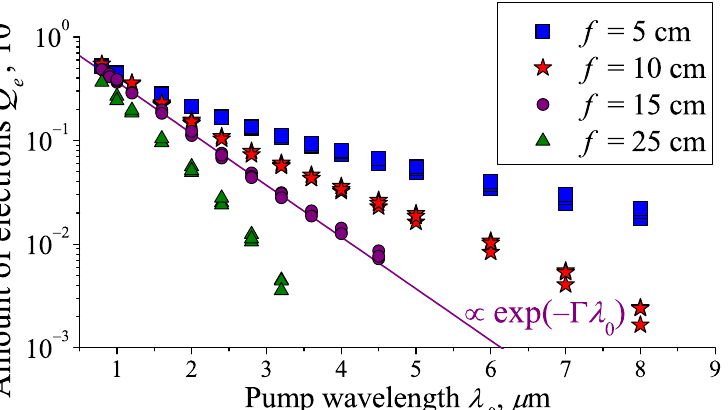
Figure 2. Dependences of the overall amount of free electrons in the filament Q e (see Equation (12)) on the pump wavelength λ 0 for four focal distances: 5 cm (blue squares), 10 cm (red stars), 15 cm (violet circles), and 25 cm (green triangles). Every pair ( λ 0 , f ) is represented by three points corresponding to three UPPE runs with different phases ϕ , resulting in a slightly different amount of